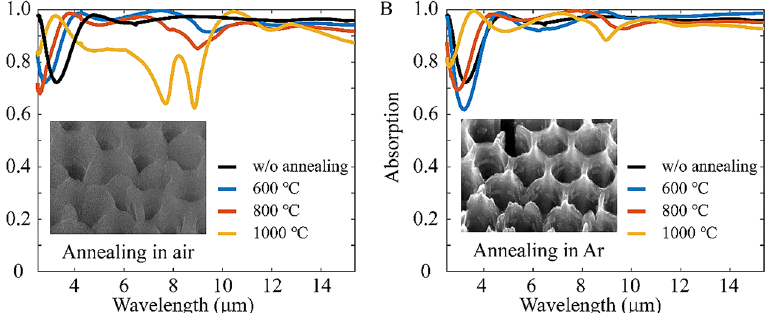
Figure 5: Room-temperature absorption of theas-preparedabsorber(blackline)andof the absorber after annealing at 600 (blue line), 800 (red line), and 1000 ° C (yellow line) for 30 min under (A) air and (B) Ar at- mospheres. The nearly unchanged absorp- tion demonstrates the high-temperature tolerance of the absorber. The inset SEM images show the surface of the device after annealing at 1000 ° C in air and Ar.